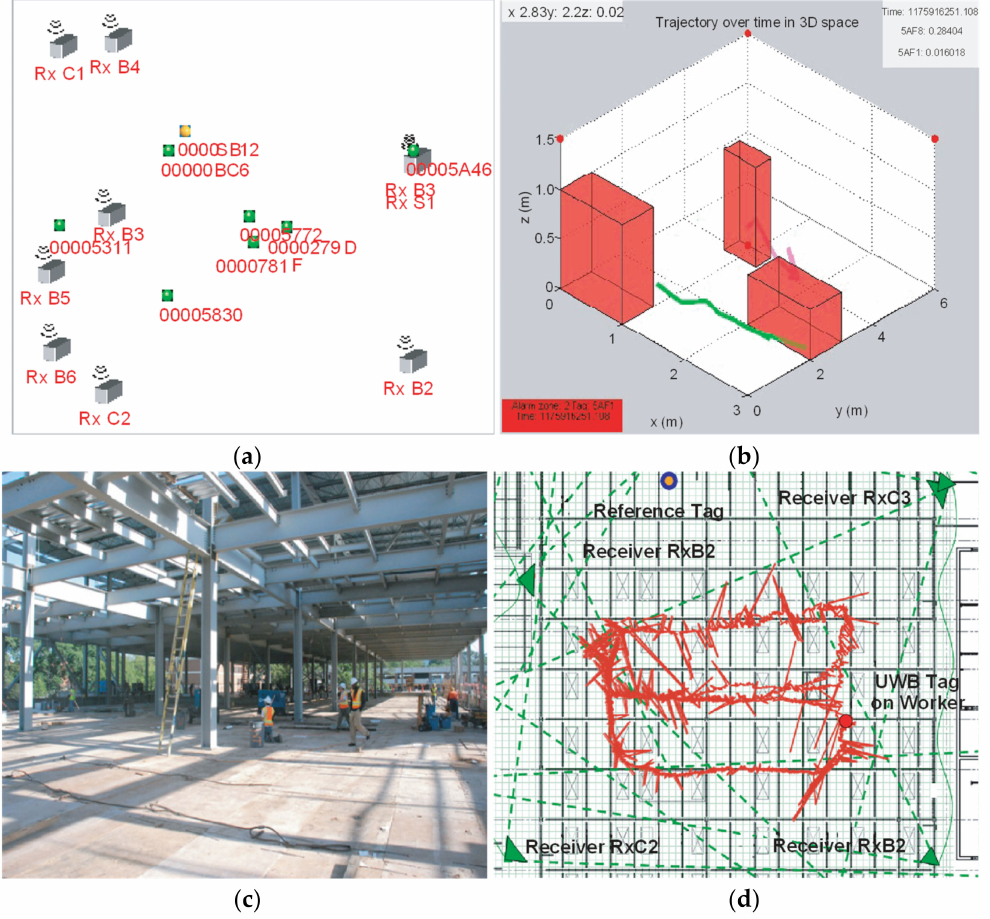
Figure 4. Experiments for obstacle avoidance and field personnel tracking: ( a ) receiver (Rx . . . ) and tag (00 . . . ) layout during field trial; ( b ) predefined hazardous areas, UWB path, and alarm box; ( c ) steel structure in field trial; and ( d ) unfiltered UWB data on the trajectory of a worker